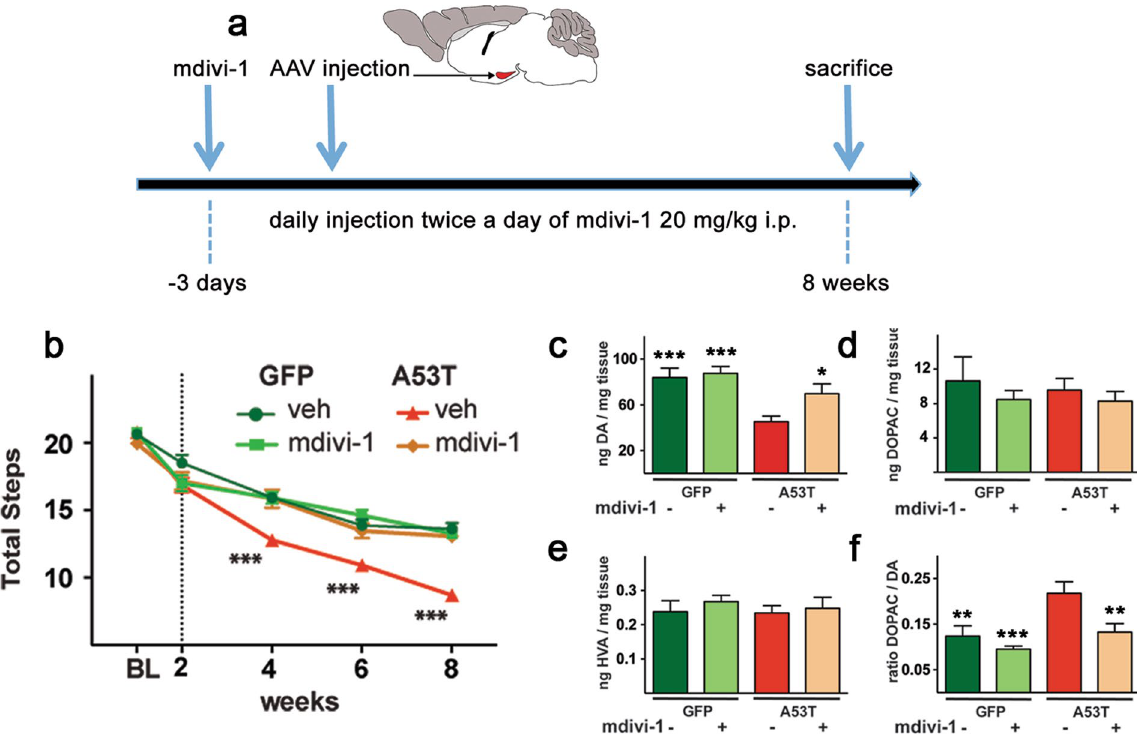
Figure 1. Mdivi-1 preserves motor function, dopamine levels and dopamine turnover rate against hA53T- α -syn-induced neurotoxicity. ( a ) Schematic illustration of the experimental design. ( b ) Sprague Dawley rats (6 weeks old) were assessed for locomotor function using stepping test. Afterwards, these animals were either injected with mdivi-1 (20 mg/kg, i.p) or vehicle control twice daily for the whole duration of the experiment. Three days after the initiation of mdivi-1 treatment, animals were stereotaxically injected with either AAV- hA53T- α -syn or AAV-GFPdegron control. Motor function was assessed every second week. Mdivi-1 treatment prevented motor deficits induced by hA53T- α -syn. HPLC was used to quantify total striatal dopamine (DA) content ( c ) as well as DA metabolites, ( d ) 3,4-Dihydroxyphenylacetic acid (DOPAC) and ( e ) Homovanillic acid (HVA). hA53T- α -syn induced significant DA depletion and increased DA turnover as evidenced by the ratio of DOPAC/DA ( f ). Mdivi-1 reduced this high turnover rate of DA ( e ) and restored the normal striatal level of DA ( c ). Mdivi-1 had no effect when injected in control animals (GFP). ( b ) Values are means ± SEM for 7–8 rats and were analyzed by 2-way ANOVA. (time: F 4,135 = 224.5 p < 0.001; treatment: F 3,135 = 32.81 p < 0.001; time x treatment: F 12,135 = 5.651 p < 0.001) followed by Tukey multiple comparison test (p < 0.001 versus hA53T- α -syn vehicle injected animals). Data from neurochemistry ( c – f ) were analysed using two-way ANOVA (AAV injection: F 1,26 = 10.57 p = 0.003; treatment: F 1,26 = 7.916 p = 0.009; AAV injection x treatment: F 1,26 = 1.984 p = 0.1708) followed by Tukey multiple comparison test ( * p < 0.05; ** p < 0.01; *** p < 0.001 compared to A53T